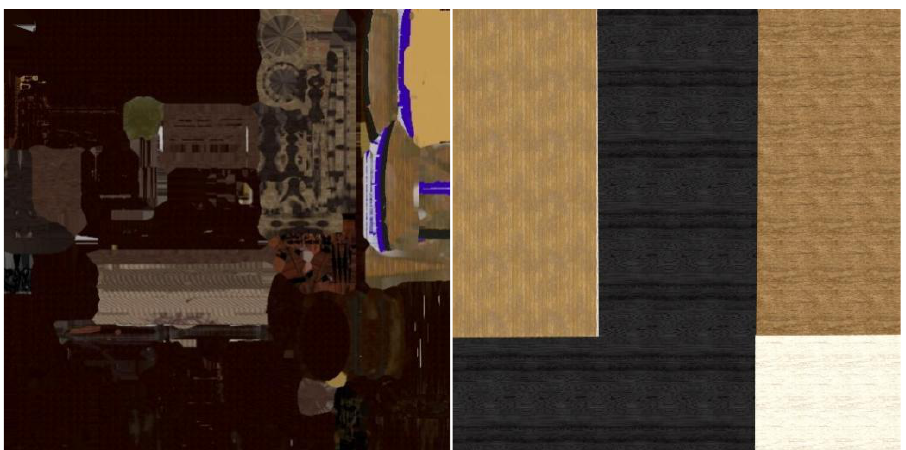
Figure 11 . Maps created by Adobe Substance 3D Painter.